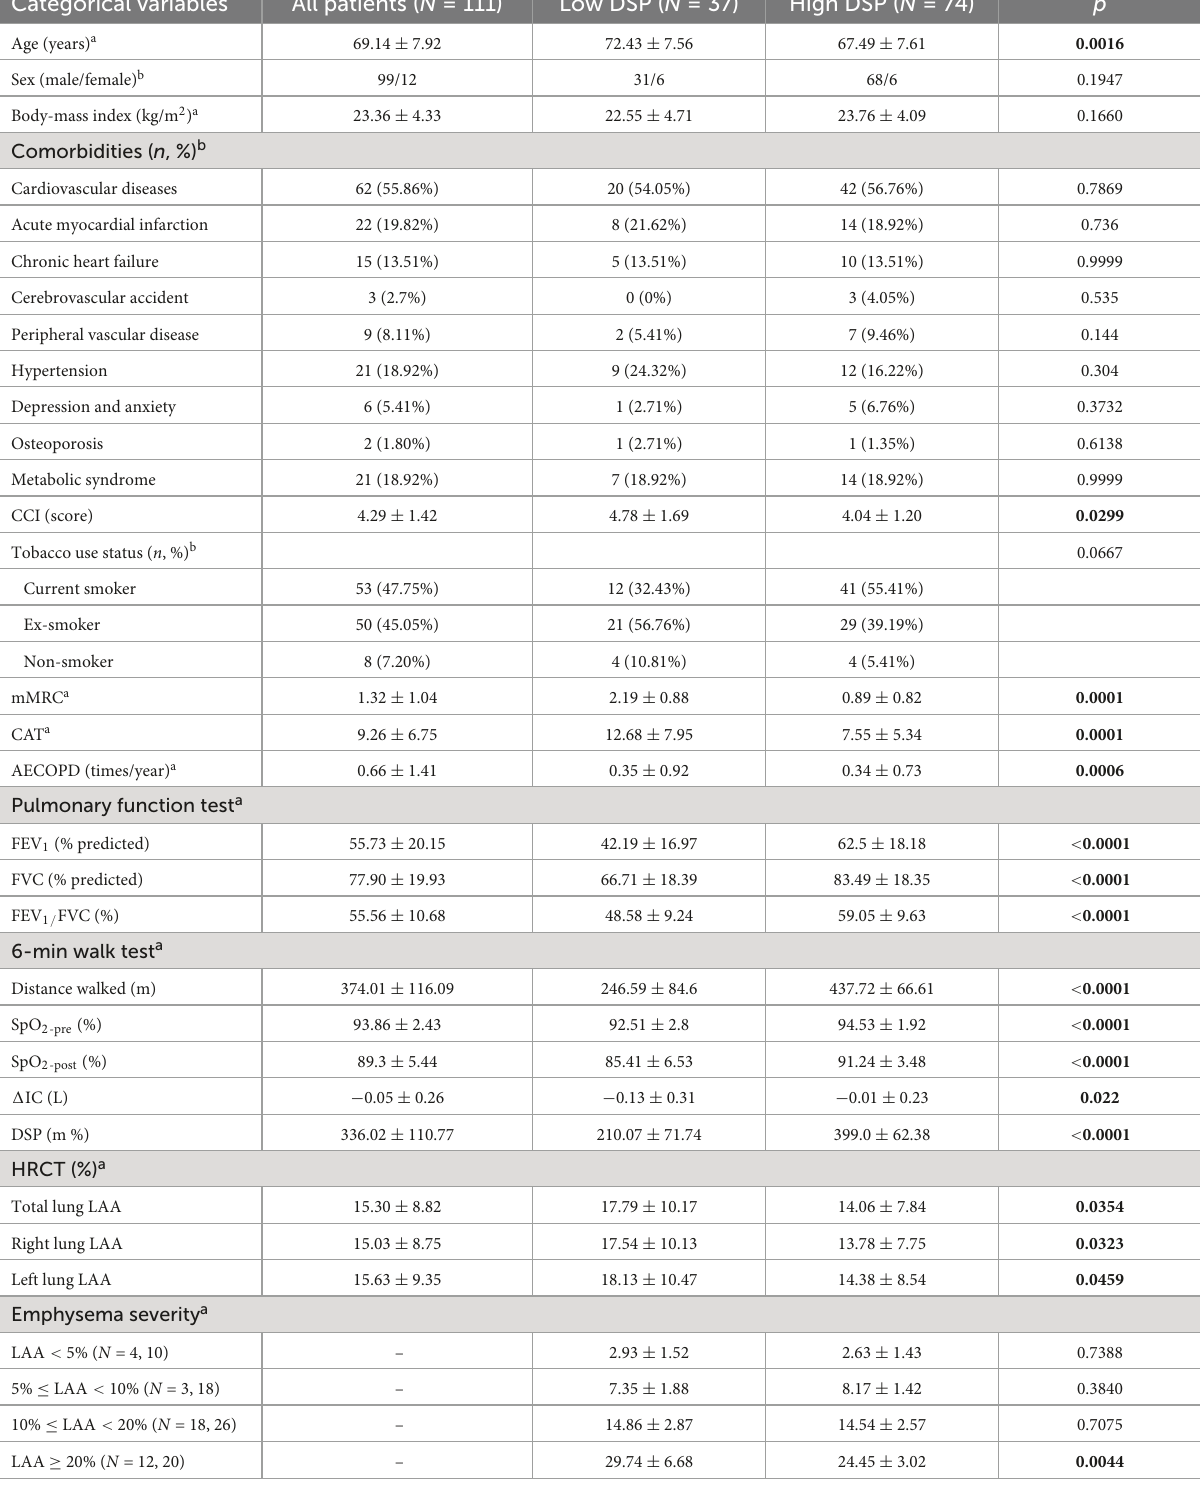
TABLE 1 Demographic characteristics of subjects grouped by the distance-saturation product